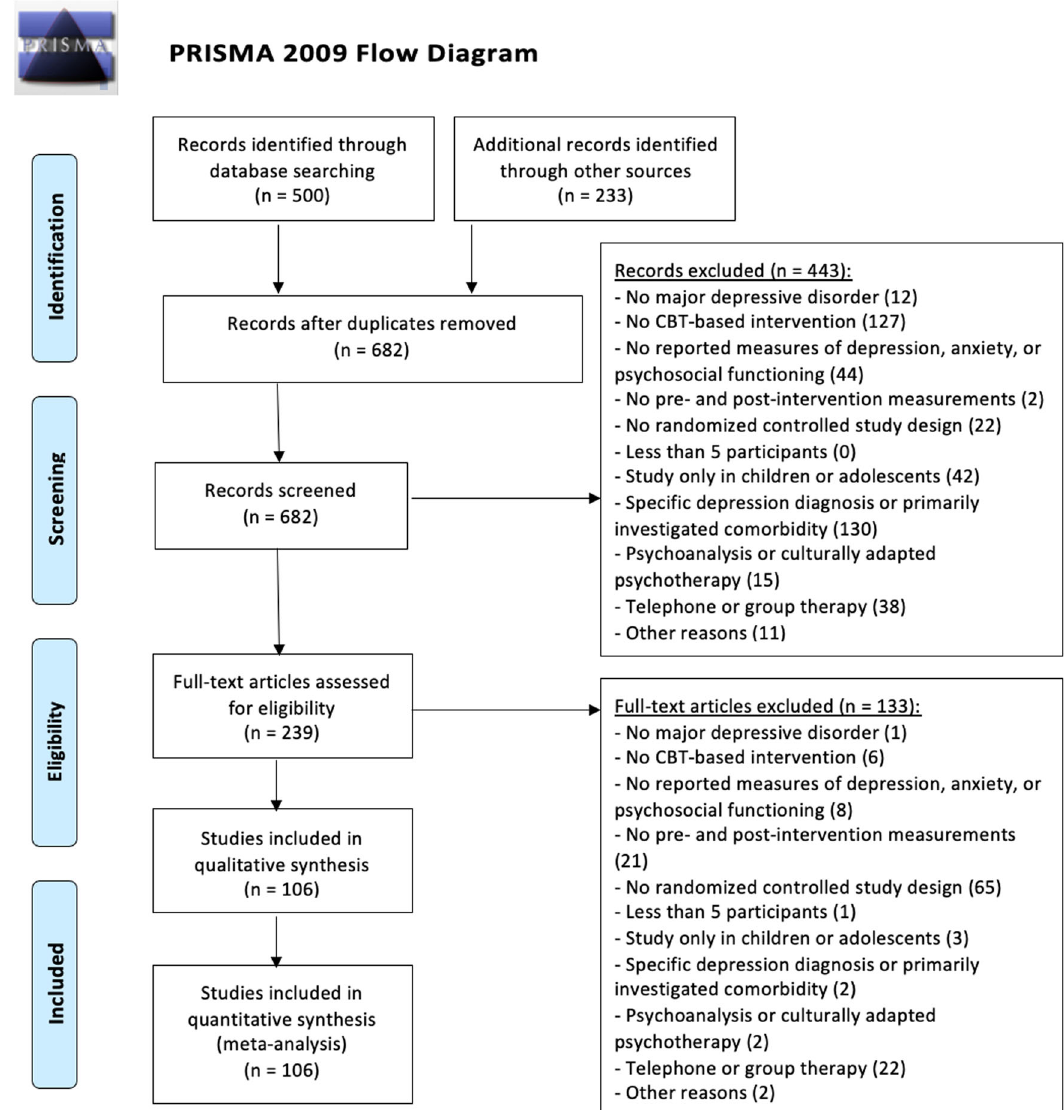
Fig. 1 Flow-chart of the literature search according to the recommendation of the PRISMA